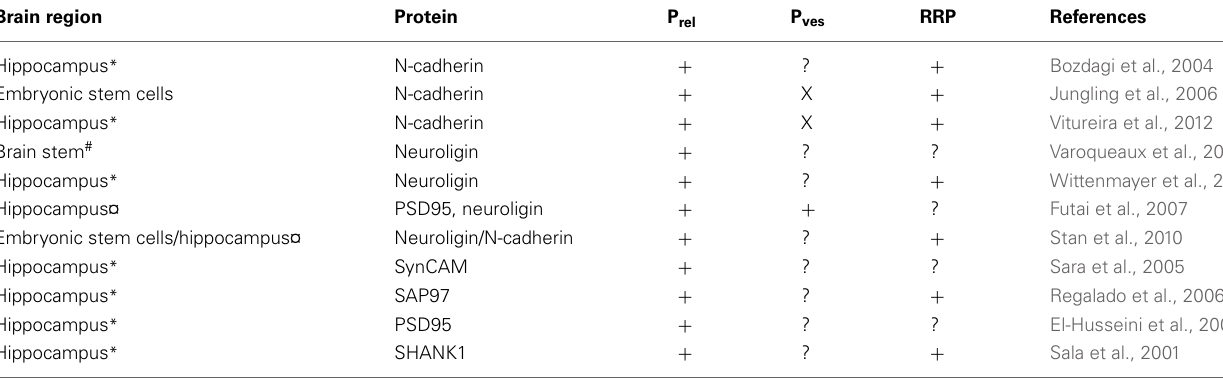
Table 1 | Postsynaptic molecules governing presynaptic transmitter release. Brain